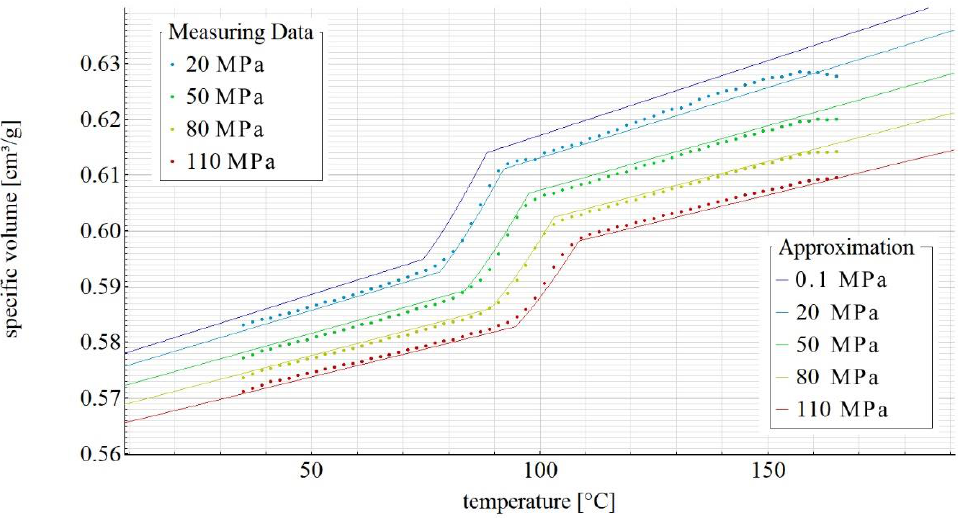
Figure 5. p-v-T diagram for polybutylene succinate containing 50% by weight of ground wheat bran.